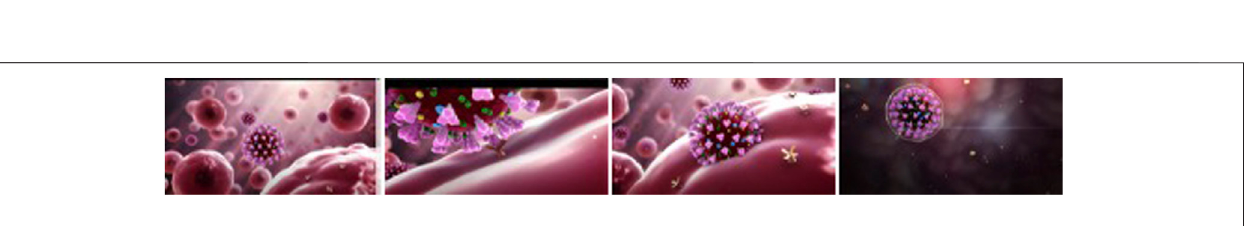
FIGURE 5 | Dynamic processes of virion (Scienti fi c Animations,